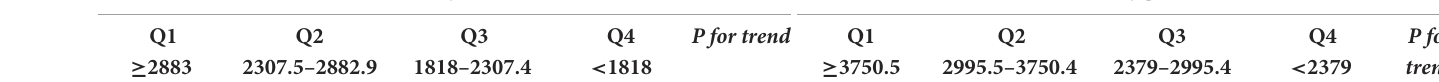
TABLE 3.2 Associations of FEV1 and FVC with cardiovascular mortality in U.S. adults aged at least 20 years among different